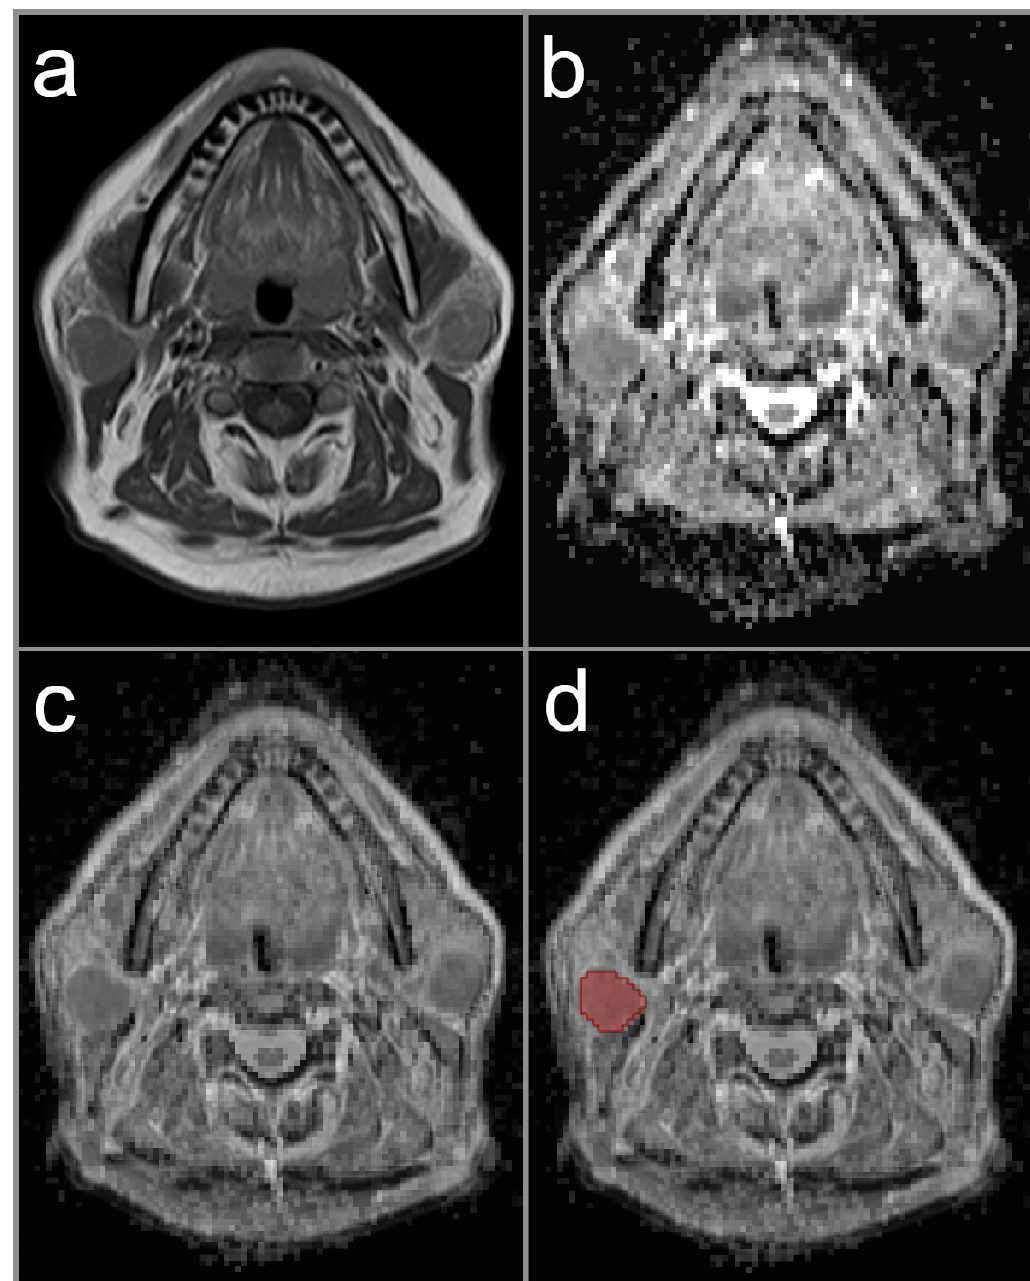
Figure 2. Image illustrating a study patient with bilateral Warthin tumors (red area indicates lesion on this particular slice). The image on the left upper row ( a ) displays native T1-weighted image with hypointense signal intensity of the tumors. The image on the right upper row ( b ) shows the parametric ADC map, illustrating the characteristic low ADC values of Warthin tumor. The image on the left lower row ( c ) represents the co-registration of the ADC map and T1-weighted image with a mix ratio of 50 %. The image on the right lower row ( d ) illustrates the co-registered image with the region-of-interest illustrated on the right side. The right parotid lesion was chosen due to its bigger size.